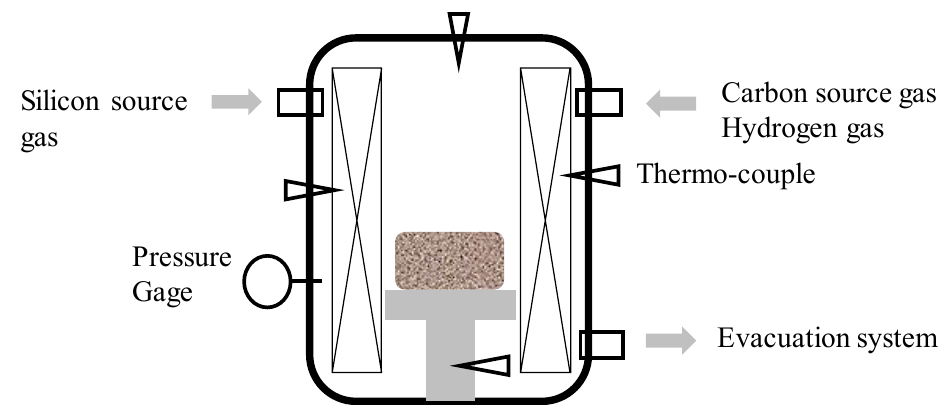
Figure 1. Illustration on the thermal chemical vapor deposition (CVD) system for SiC coating.